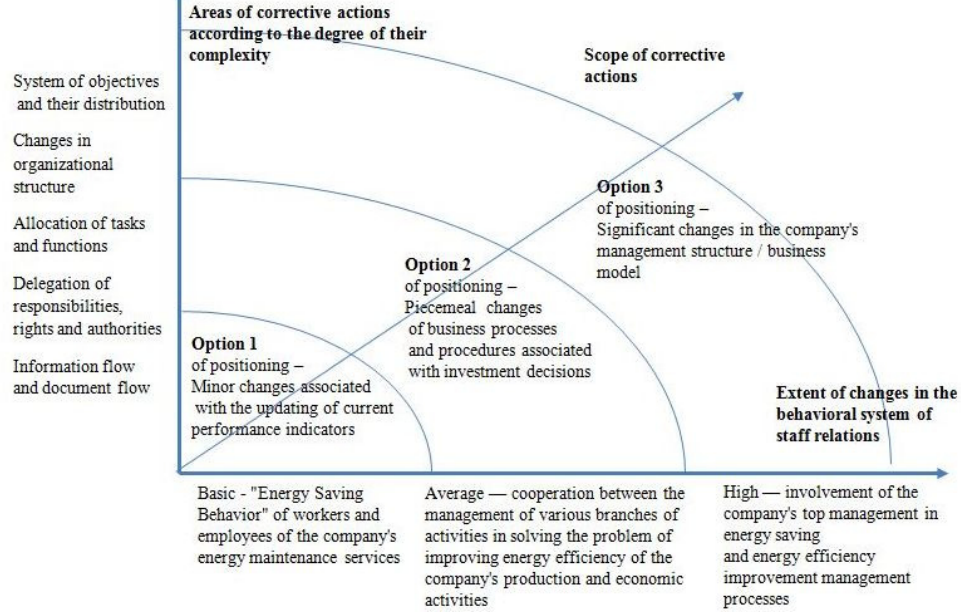
Figure 3. Potential changes in the behavioral system of staff relations at different options of the positioning of energy saving and energy efficiency improvement (source: compiled by the authors).